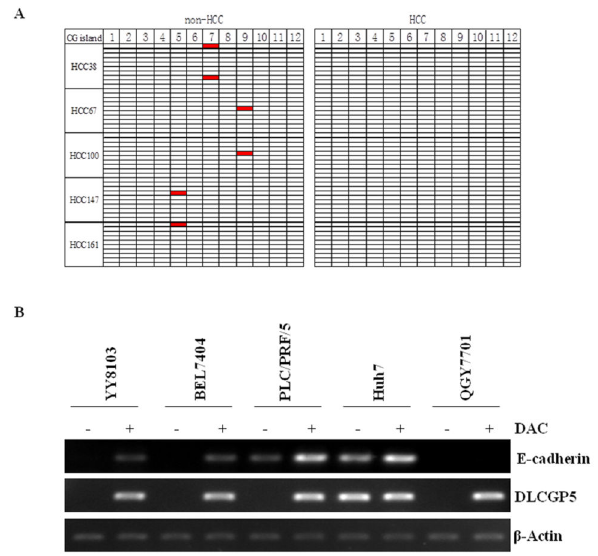
Figure 6. The DNA methylation status of DLGAP5 promoter in HCCs. (A) Results from the bisulfite sequencing analysis of DLGAP5 promoter CpG methylation in five pairs of HCC and non-HCC specimens. Each box indicates a CpG dinucleotide within the CpG island in the promoter. (B) YY8103, BEL7404, PLC/PRF/5, Huh7 and QGY7701 cells were treated with 5-aza-2'-deoxycytidine (DAC, work concentration: 2.0uM). The expression of DLGAP5 was then evaluated by RT-PCR. Untreated HCC cells were employed as control. E-cadherin, a well-known hypermethylation-silenced genes in HCC, was used for positive control.